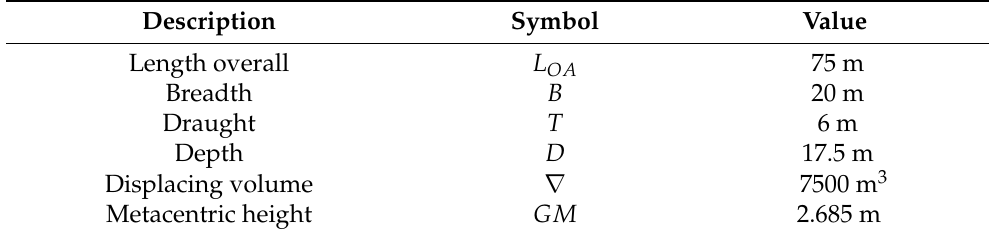
Table 1. Main particulars of the test geometry.